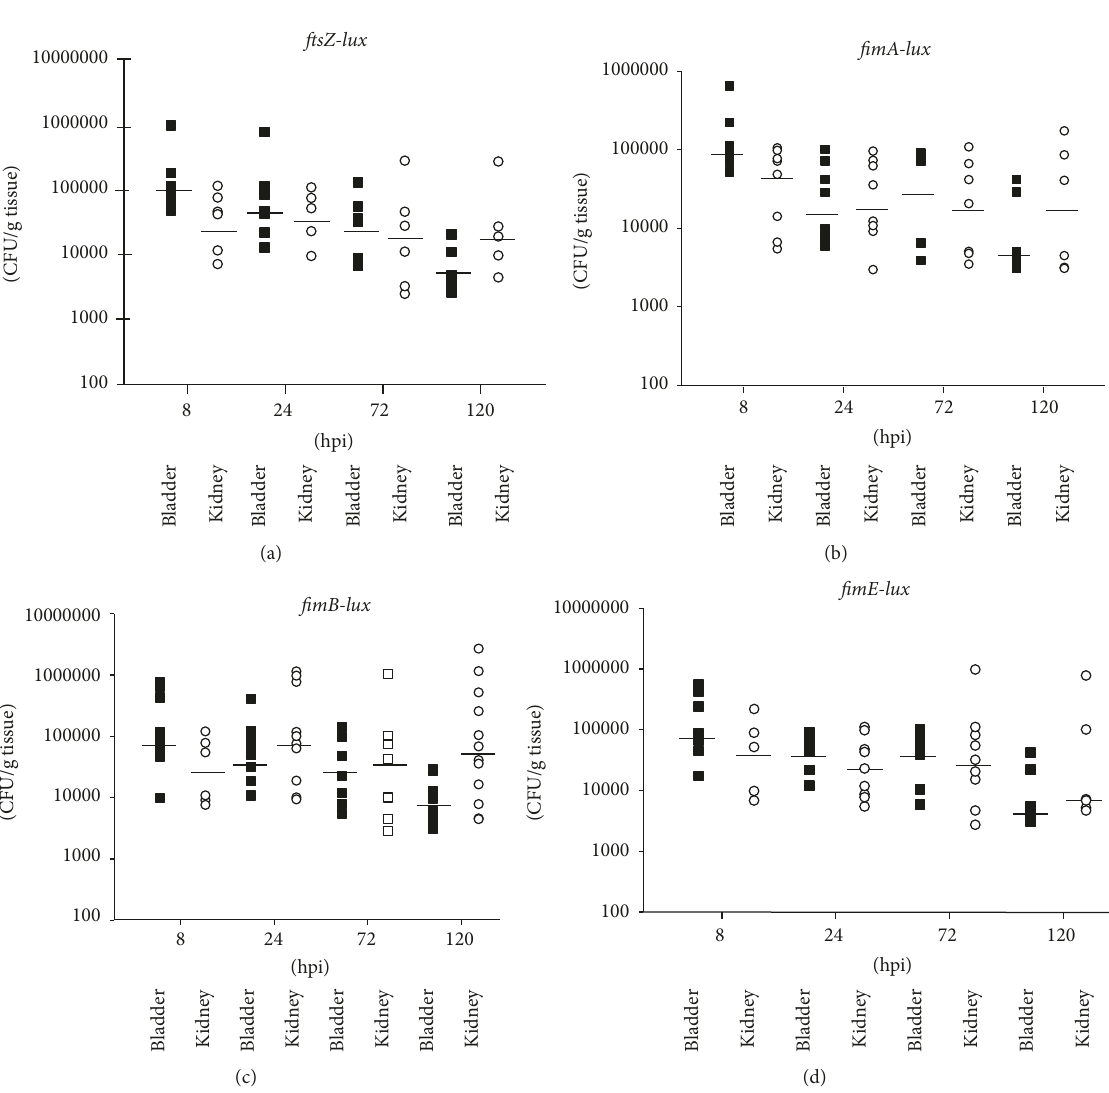
Figure 2: Viable counts of E. coli strain NU149 containing different fim-lux fusions in infected murine bladders and kidneys after 8, 24, 72, and 120 hours after inoculation (hpi). Murine tissues included bladders (black square) or kidneys (white circle) from the ftsZ (a), fimA (b), fimB (c), and fimE (d) fusion cultures. Five to twelve animals per time point were examined where each symbol represents one mouse. The black horizontal bars represent the median values for each time point and